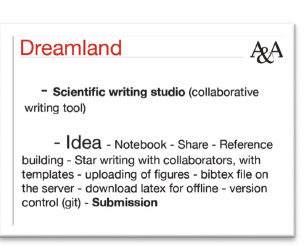
Figure 1. Some of the special issues published by Astronomy